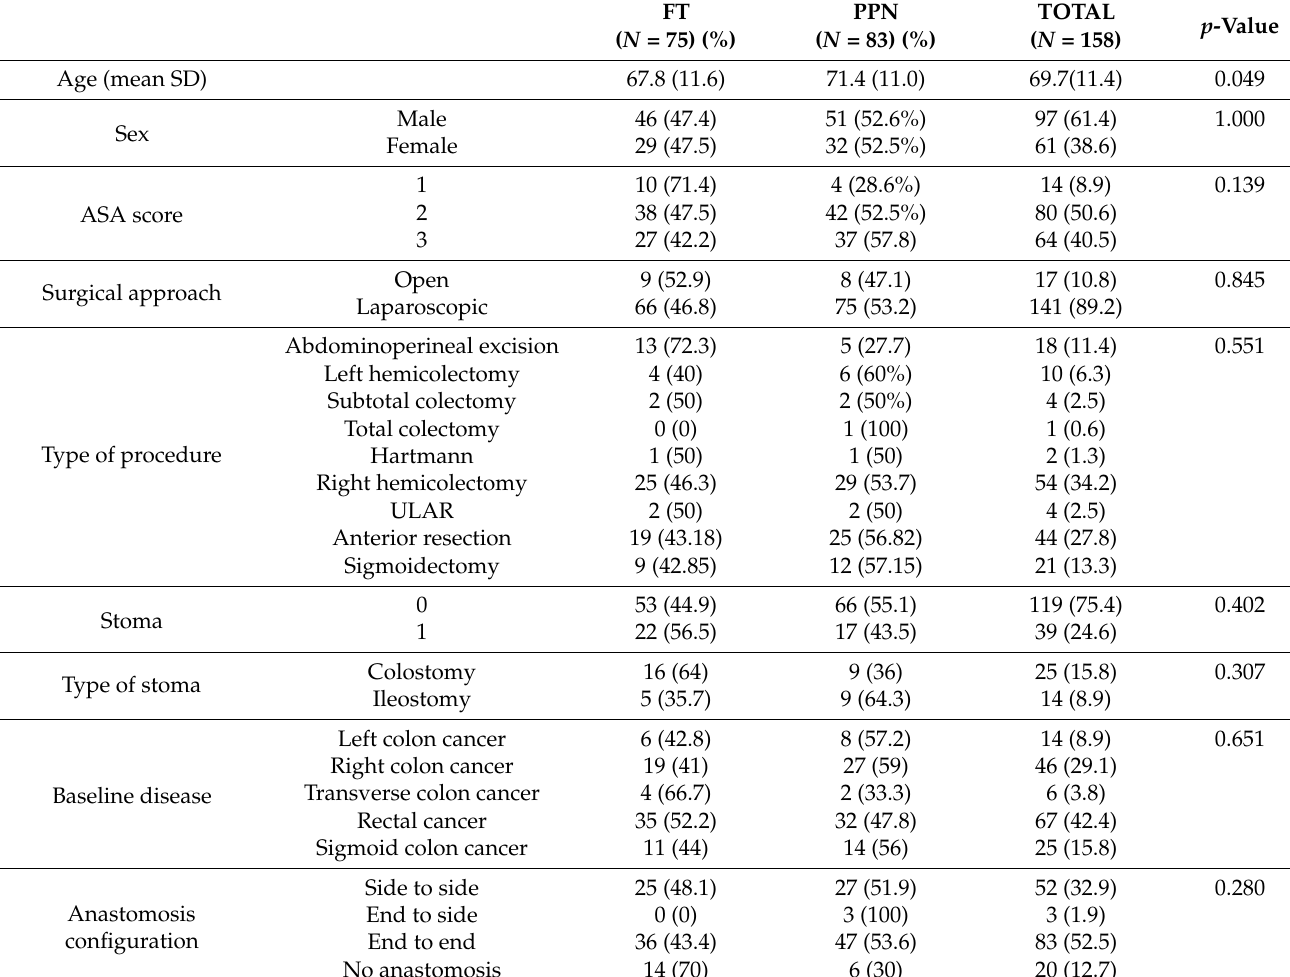
Table 1. Demographic, preoperative, surgical, and pathological data of study